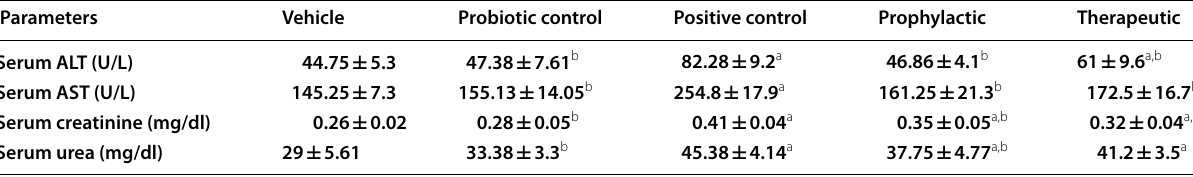
a Significant difference compared to vehicle group b Significant difference compared to positive control